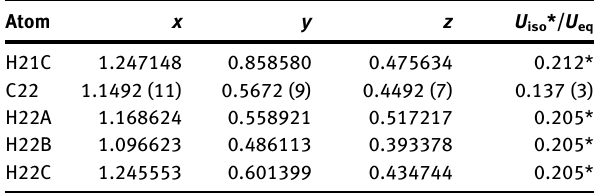
Table  : Fractional atomic coordinates and isotropic or equivalent isotropic displacement parameters (Å 